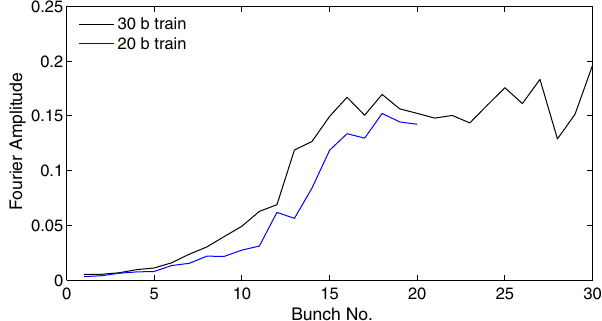
FIG. 10. Amplitude at vertical tune, obtained from FFT of vertical bunch motion (in mm), as a function of bunch number for two train lengths.